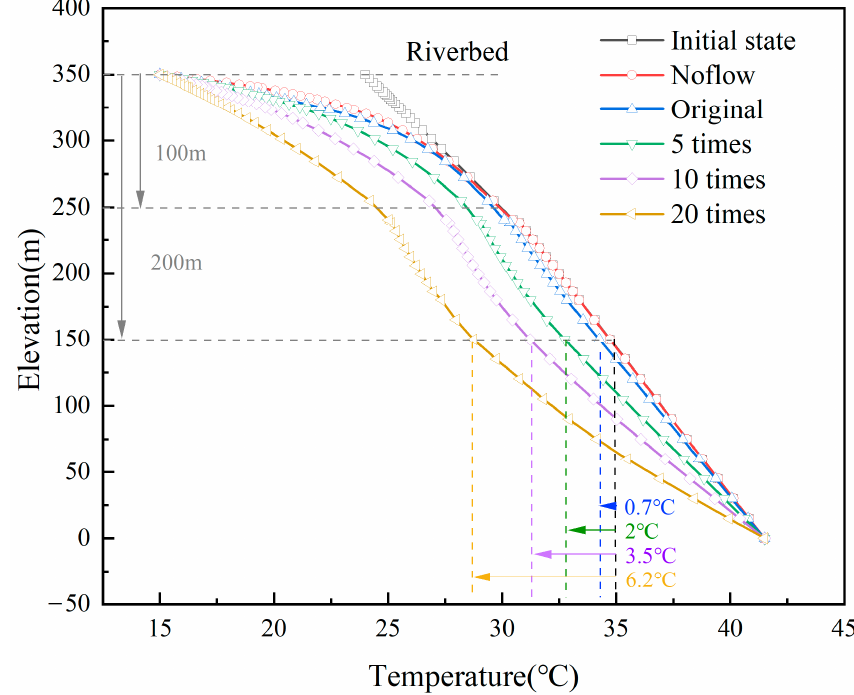
Figure 16. The bedrock temperature at different depths after 10 years of reservoir impoundment.